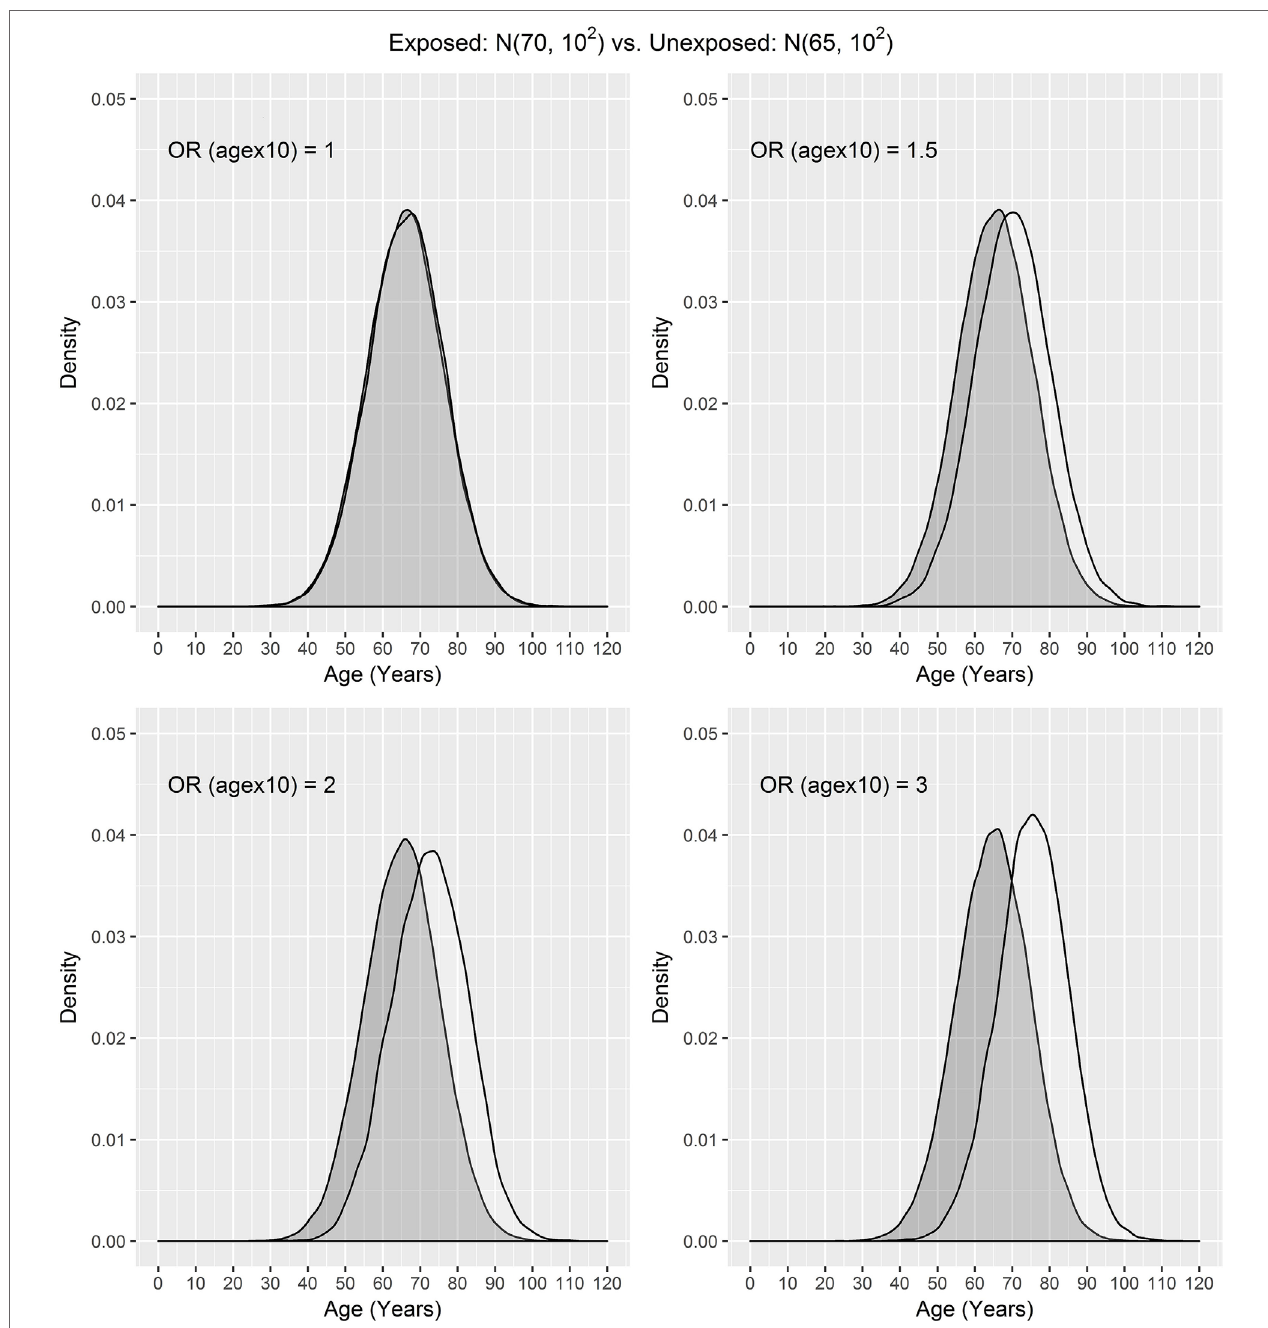
FigUre 1 | Age distributions of cases (white) and controls (grey) in the population, where the age distributions of exposed and unexposed subjects are N (70, 10 2 ) and N (65, 10 2 ), respectively, and OR (agex10) denotes odds ratio associated with a 10-year increase in age.